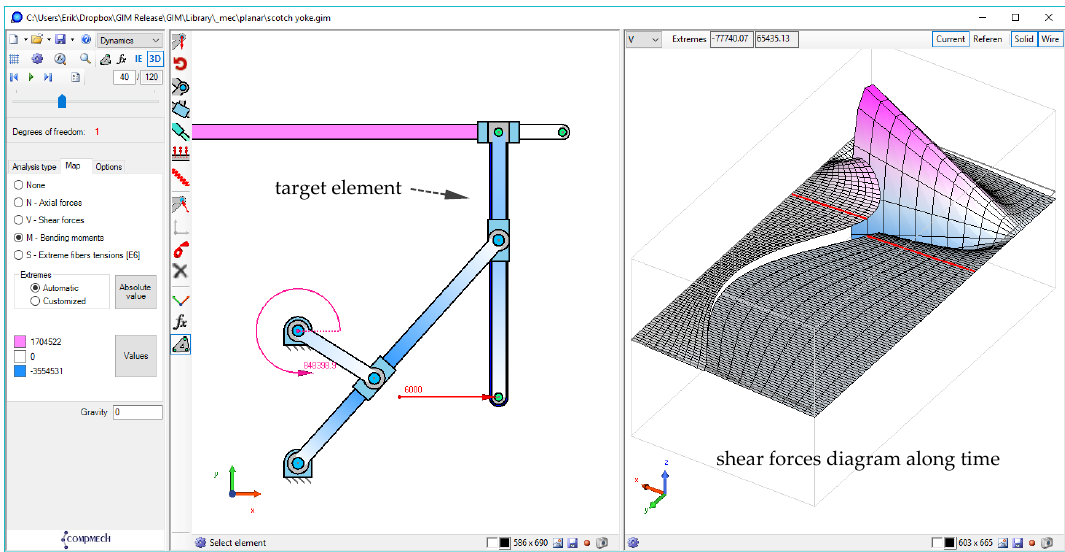
Figure 13. Free solid and internal efforts’ diagrams.